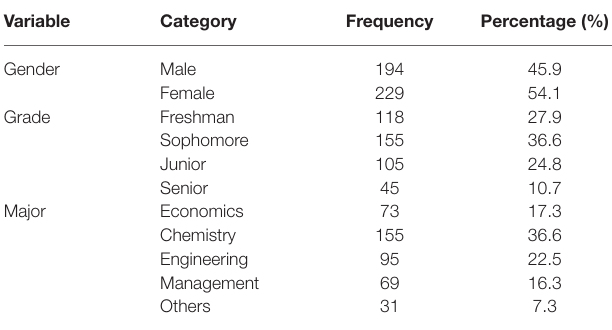
TABLE 1 | Demographic information ( N =